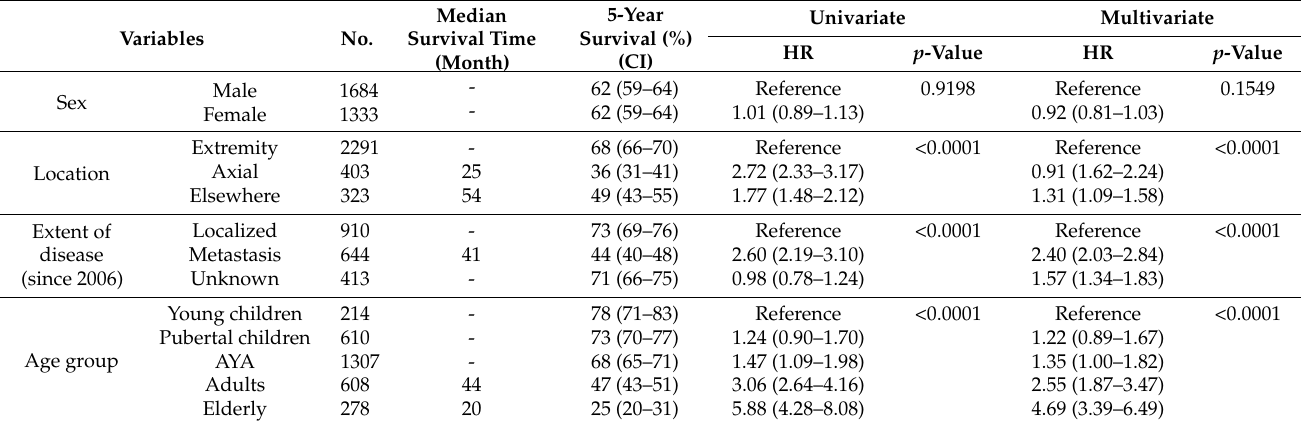
Table 3. The overall survival and hazard ratio of osteosarcoma according to clinical